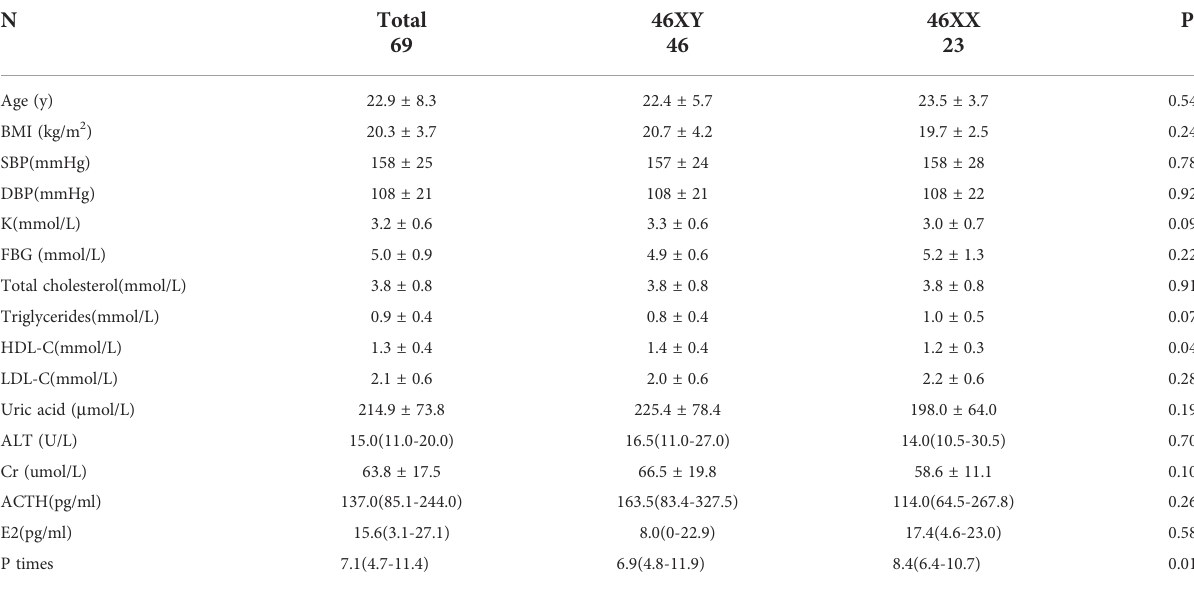
TABLE 1 Baseline clinical characteristics of 17OHD patients categorized by karyotypes.